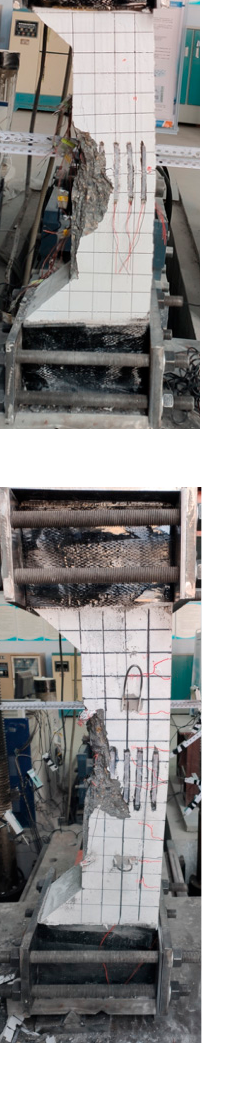
Figure 6. The failure modes of the columns with various eccentric distances: ( a ) specimen E1 with an eccentric distance of 40 mm; ( b ) specimen E2 with an eccentric distance of 120